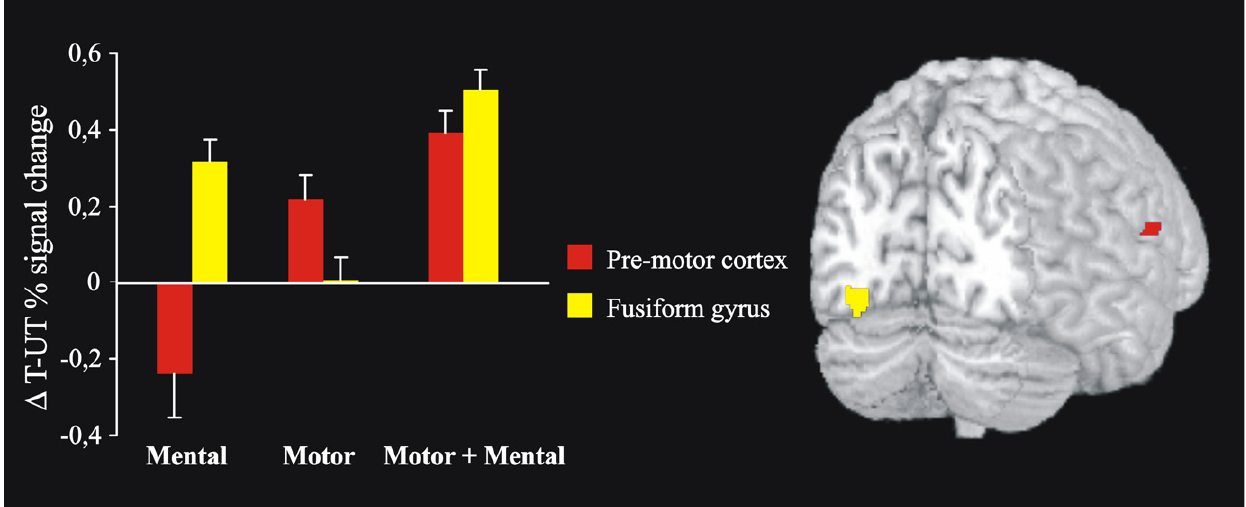
Figure 2 | After 6 weeks of motor training, a signifi cant activation increase was observed in the contralateral (right) ventral pre-motor cortex (red) during performance of the trained sequence. After mental training, activation was signifi cantly increased in the left fusiform gyrus (yellow). Both these regions showed increased activity after a combination of motor and mental training. Bars indicate differences in BOLD signal change between the trained and untrained sequences ( Δ T-UT) and error bars are standard error.